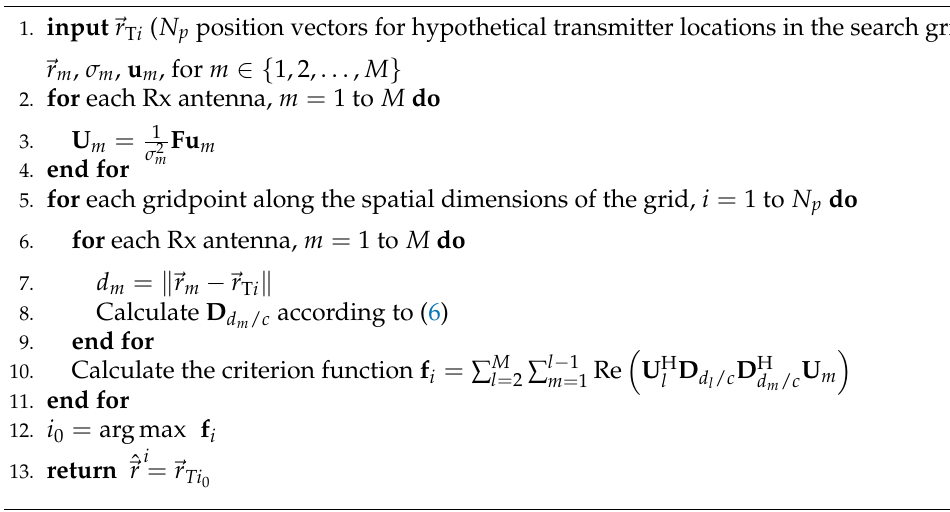
Algorithm 2 An implementation of the ML-US